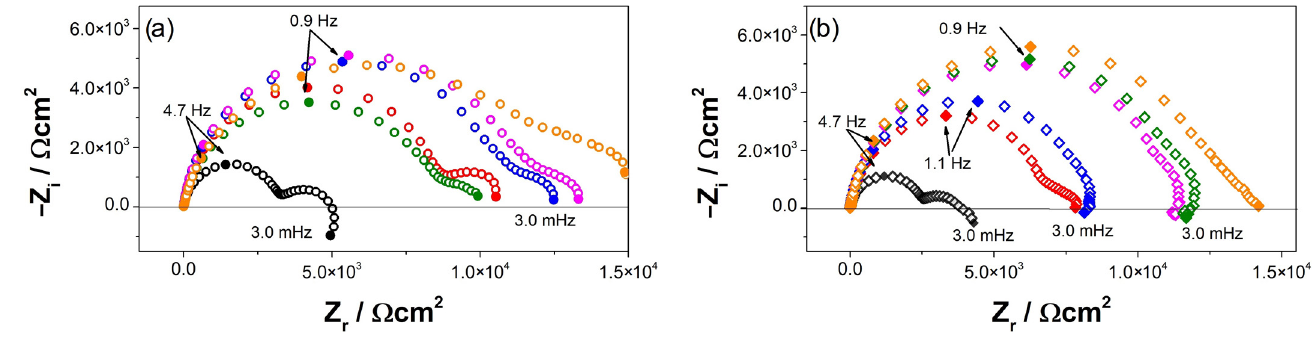
Figure 6. Nyquist diagrams evolution of ( a ) AZ and ( b ) AZ + Ar-P samples in 0.1 M of Na 2 SO 4 ,. ( ○, ◊ ) 3 h, ( ○, ◊ ) 24 h, ( ○, ◊ ) 72 h, ( ○, ◊ ) 120 h, ( ○, ◊ ) 168 h, and ( ○, ◊ ) 240 h.